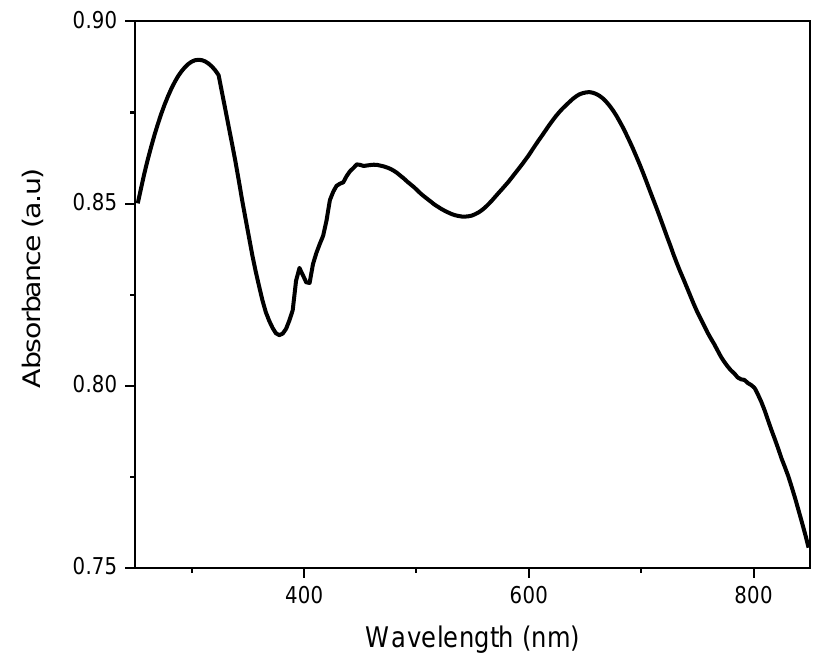
Figure 5. UV-Visible spectrum of CuO NPs.